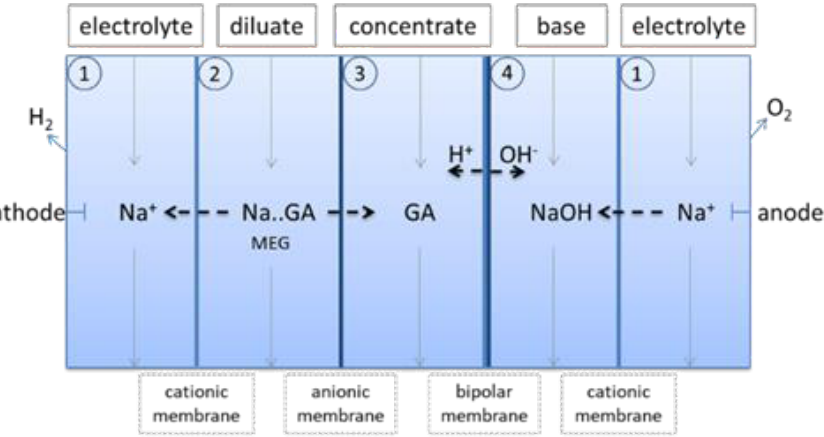
Figure 5. Setup for splitting sodium glycolate into glycolic acid and sodium hydroxide (1. electro-